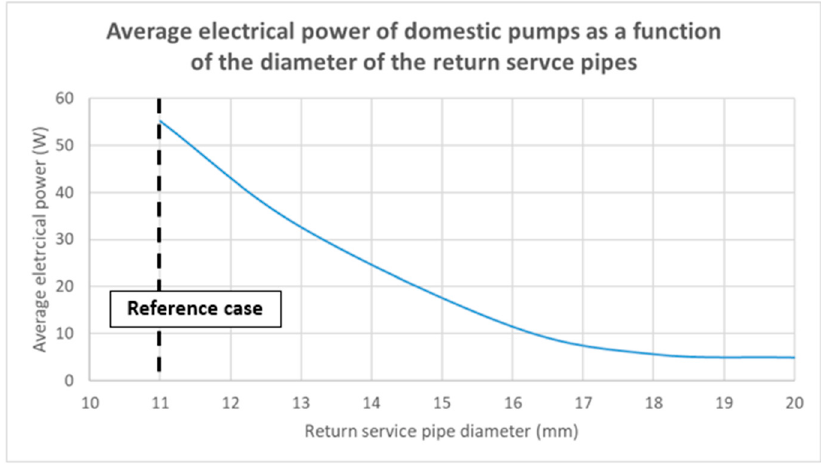
Figure 15. Improved pump operation as a function of service pipes’ diameters.